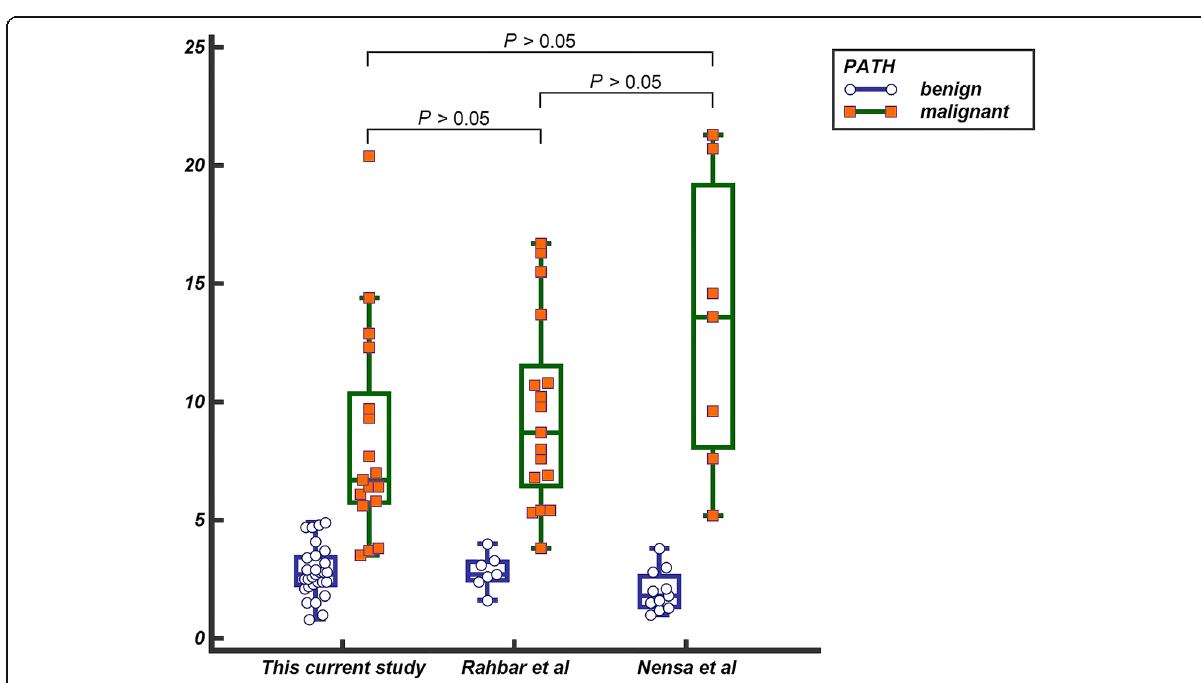
Fig. 7 Comparison of this current study with Rahbar et al. ’ s [4] and Nensa et al. ’ s [28] study. There was no statistically significant difference in the median (SUVmax) of benign and malignant groups in the above three groups ( P >